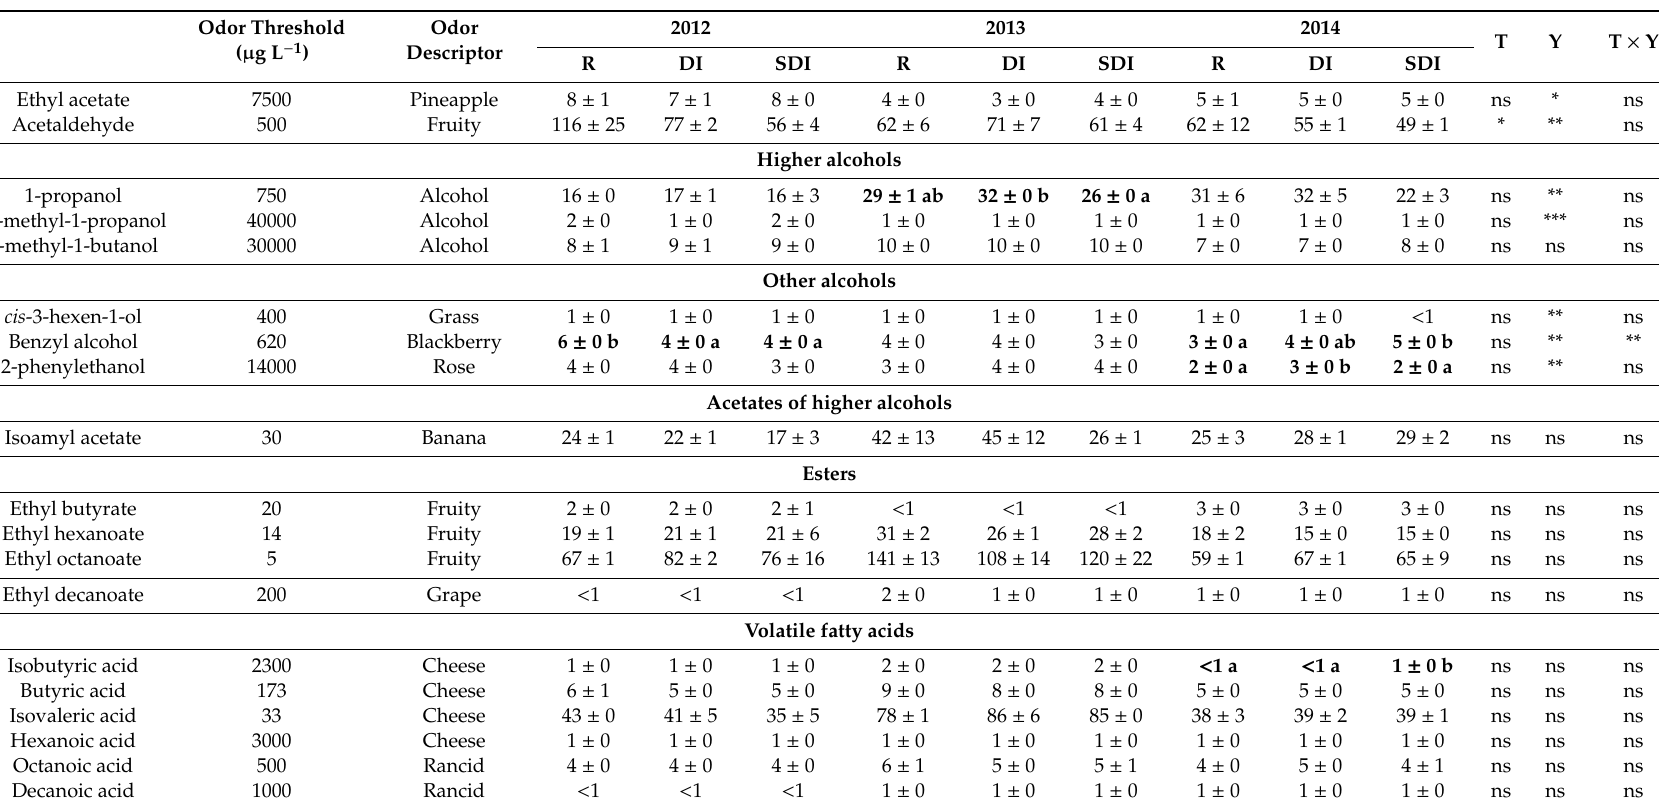
Table 7. Irrigation e ff ects on the odor activity values (mean ± standard error) of Godello wines. Odor thresholds and descriptors for each compound are displayed. The significances of the year, treatment as well as their interaction are also shown. R = rain-fed, DI = drip irrigation, SDI = subsurface drip irrigation, T = Treatment, Y =